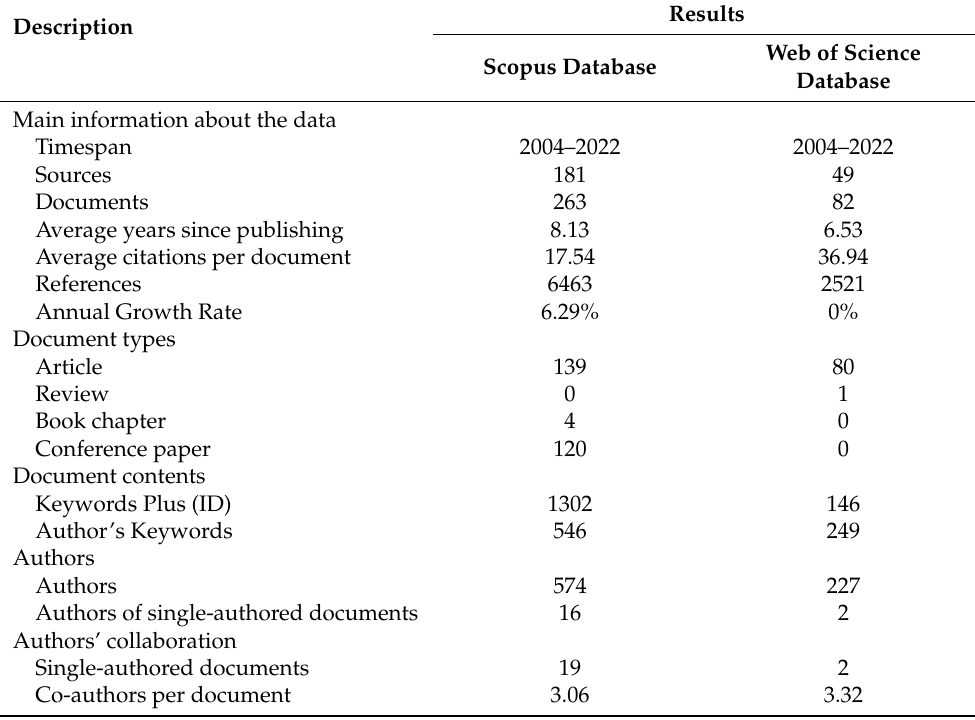
Table 4. General information about the data obtained from the Scopus and Web of Science searches.